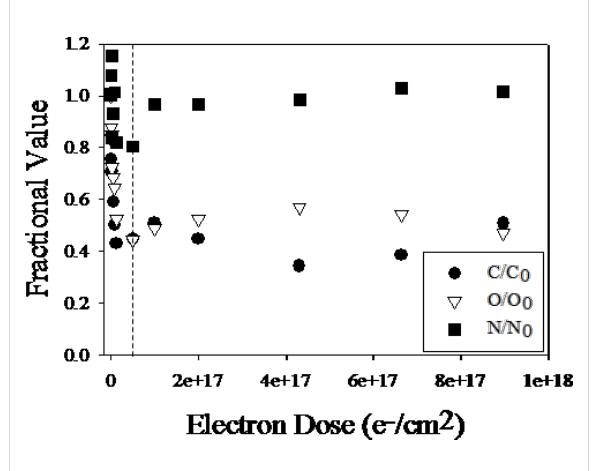
Figure 22: Electron dose dependence of the fractional coverage of carbon, oxygen and nitrogen from Co(CO) 3 NO adsorbed onto a gold substrate at 105 K and exposed to 500 eV electrons. The vertical dotted line represents an electron dose of 5 × 10 16 e − /cm 2 (repro- duced with permission from [25], Copyright (2013) American Chemical